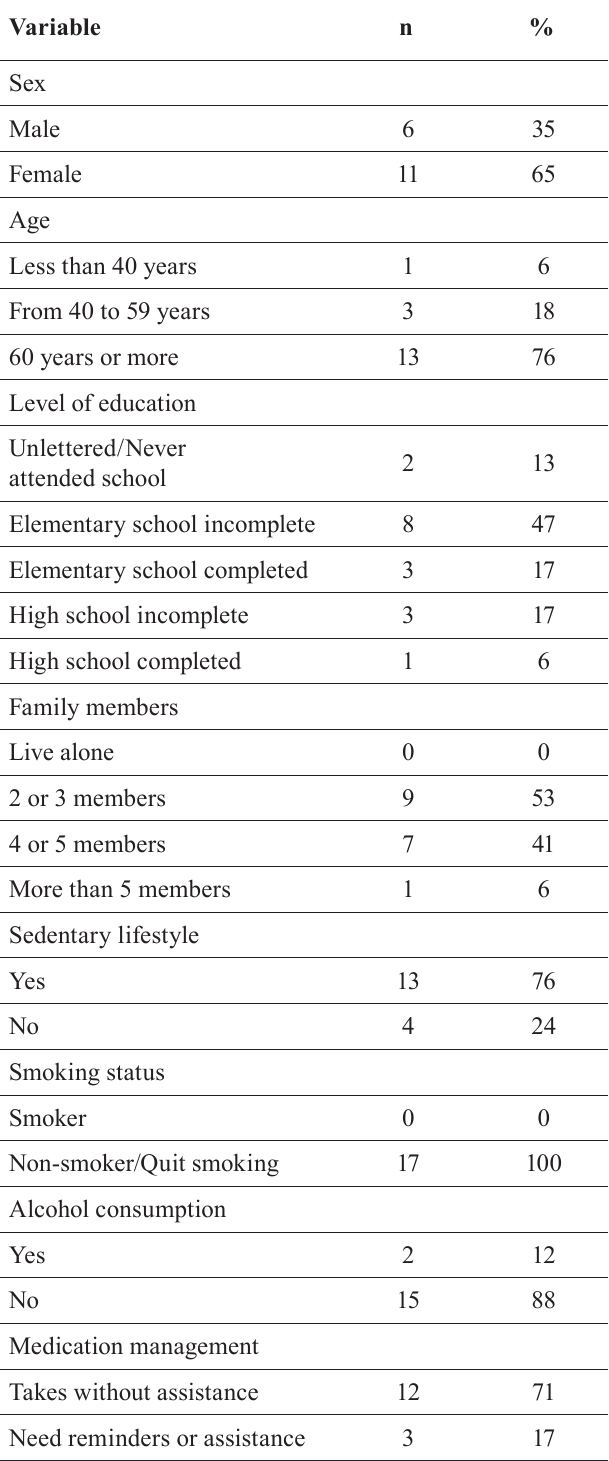
TABLE I - S ociodemographic, behavioral and drug utilization characteristics of T2DM patients included in the Pharmaceutical Care Program for the pharmacotherapeutic management at UP, Juiz de Fora-MG, Brazil